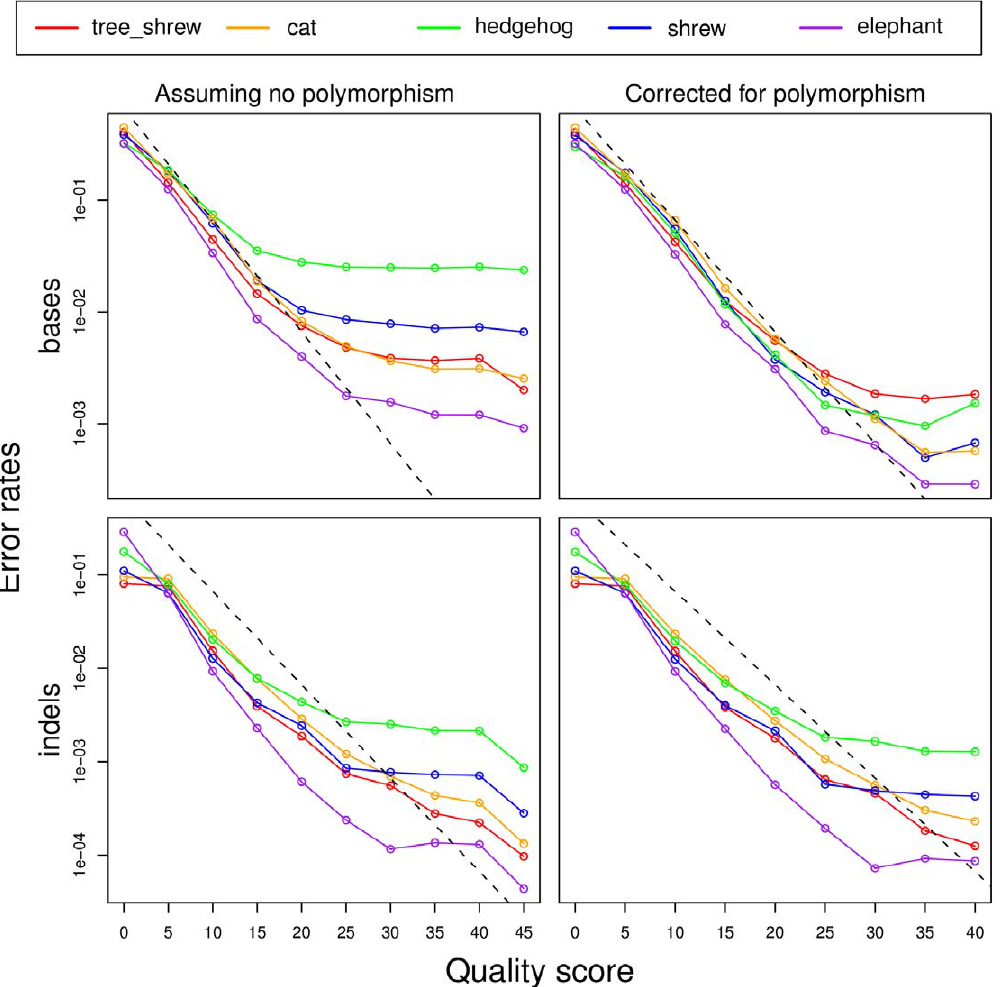
Figure 1. Quality scores vs. error rates in selected 2 6 genomes. Error rates were estimated from alignments with high-quality ENCODE sequences. Separate plots are shown for basecall (top) and indel (bottom) errors, before (left) and after (right) correcting for polymorphisms (see text). The quality score of an insertion is taken to be the minimum score of the inserted bases and the 10 nearest neighboring bases (5 on each side), while the score of a deletion is the minimum score of just the 10 neighboring bases. The dashed line shows the rates implied by nominal quality scores (i.e., error rates of 10 2 q /10 for each score q ). Note that these predicted rates include both base-call and indel errors [8], so they are expected to be slightly larger than the true rates for the individual error types. The excess of errors at large quality scores could result from an underestimation of polymorphism (perhaps because the high quality regions used to estimate polymorphism are depleted for segregating sites), or from an overestimation of quality scores (perhaps because the assembler assumes independence of reads in estimating aggregate scores). The numbers of events were sufficiently large that sampling errors were small relative to the dependency on quality scores.